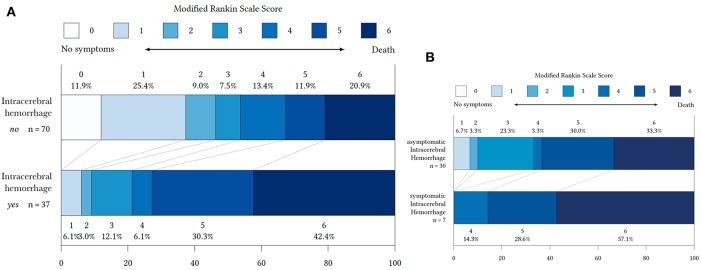
Distribution of modified Rankin Scale (mRS) at 90 days in patients with and without ICH (A) and symptomatic ICH and asymptomatic ICH (B).